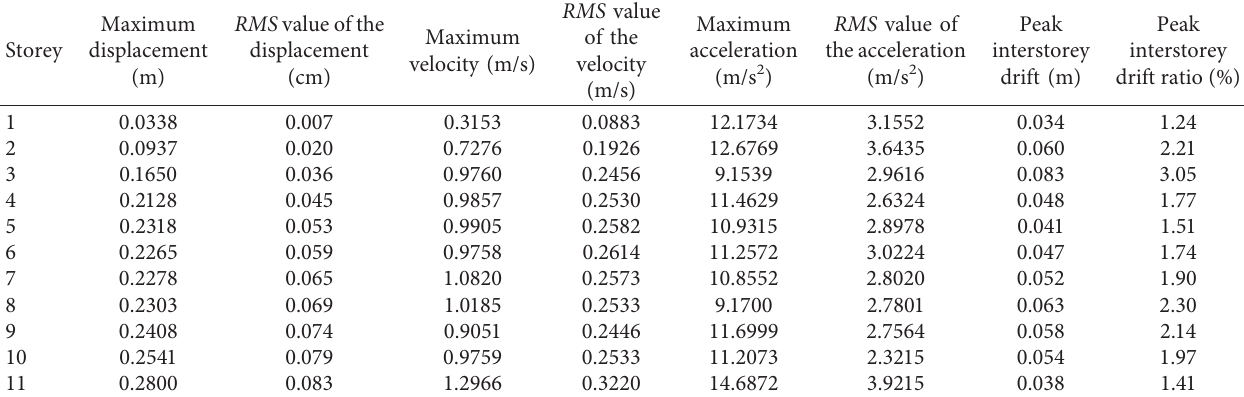
Table 6: Response of the uncontrolled structure when it is excited by “ Algarrobo ” earthquake.